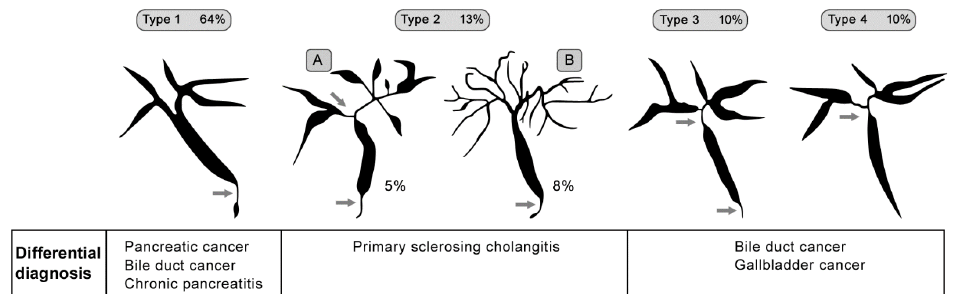
Figure 1. Classification of IgG4-related sclerosing cholangitis (prepared in accordance with Nakazawa et al. [66] and cre- ated in collaboration with the Service Center for E-Learning at Masaryk University, Faculty of Informatics).